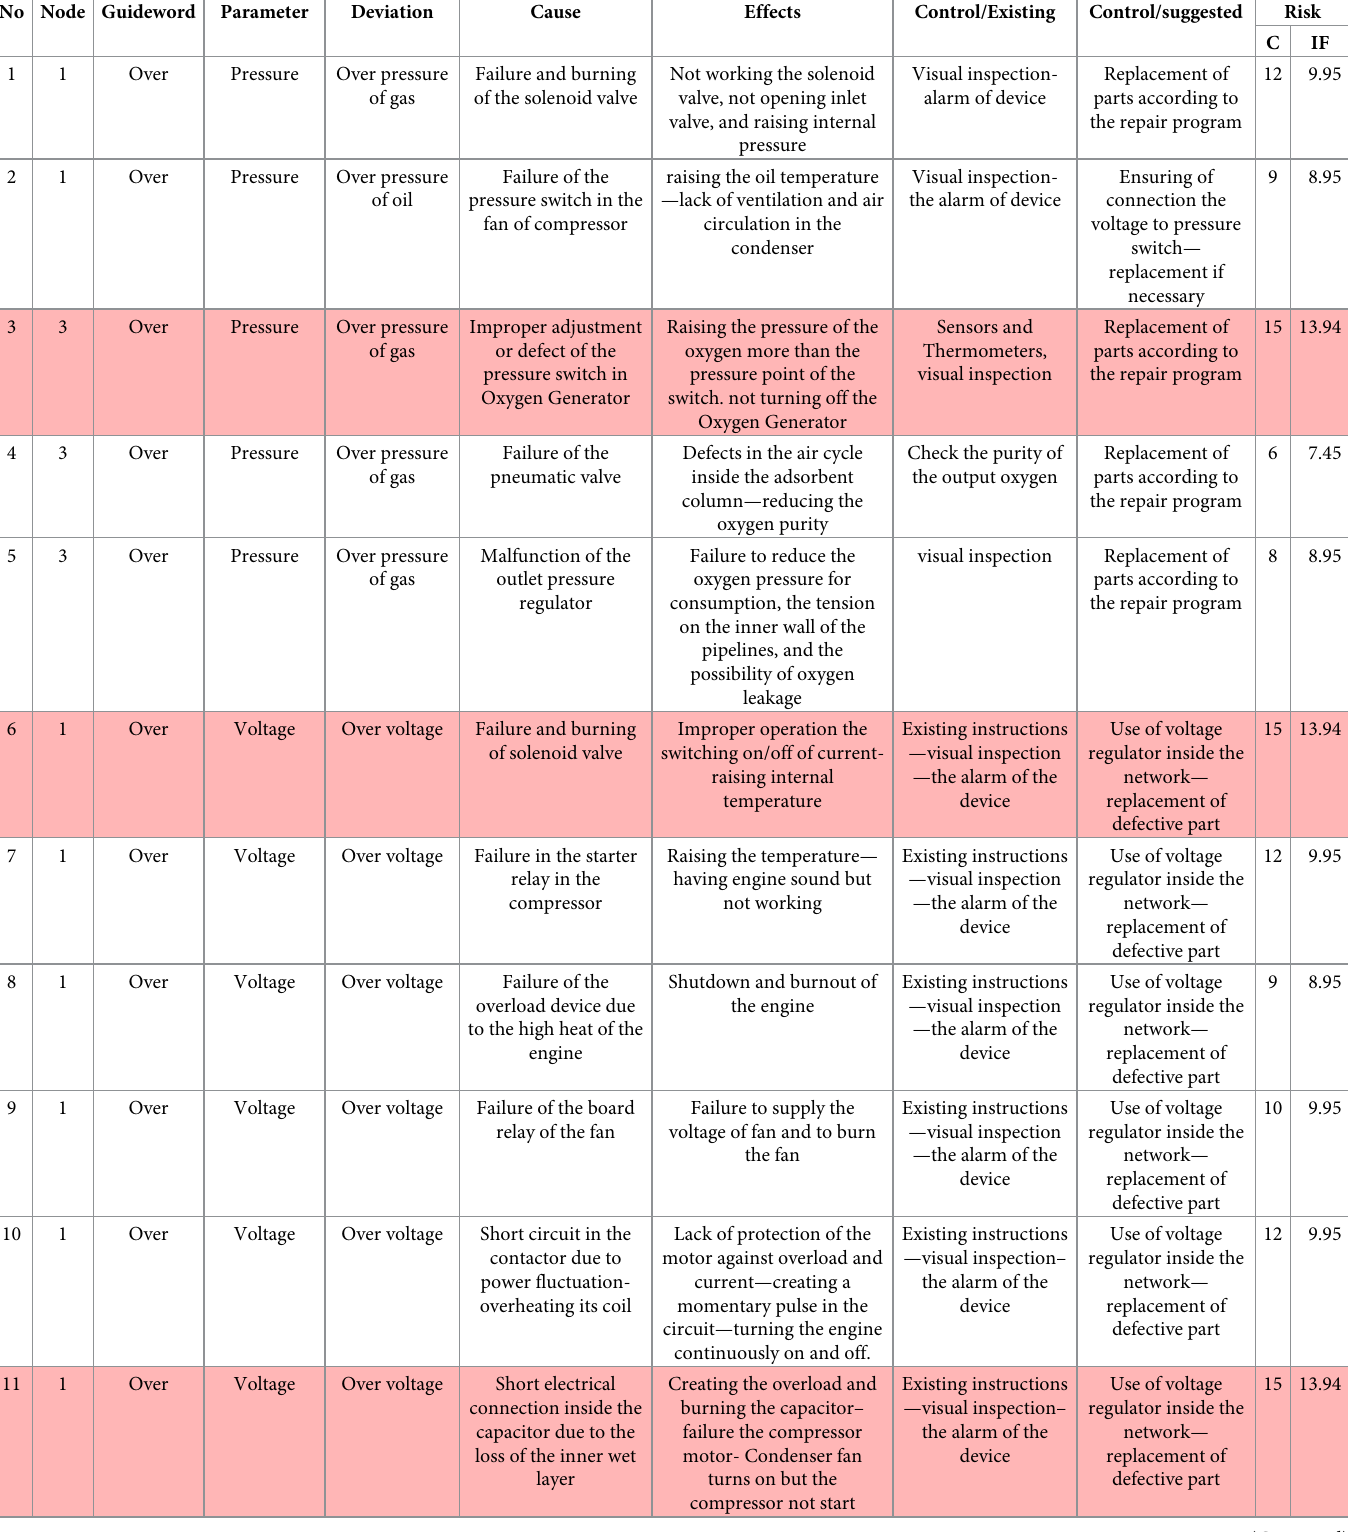
Table 6. Four critical deviations in the conventional (C) and fuzzy (IF) approaches in the PSA